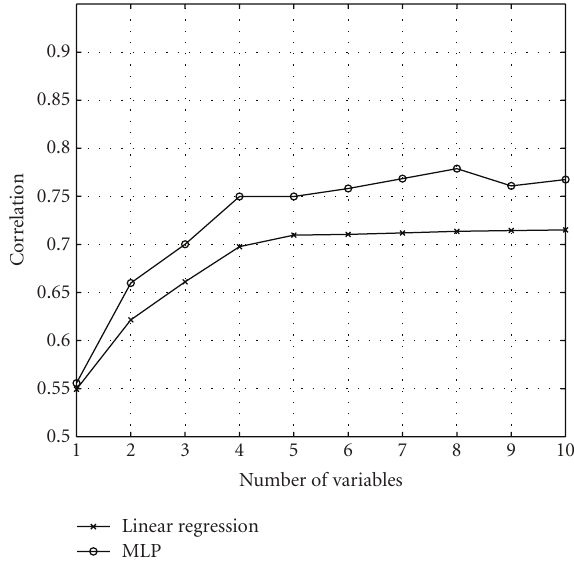
Table 4: Variables selected for turbidity using multilayer percep- trons. Figure 2: Evolution curves for turbidity. The goodness of the model improves at first as variables are added, but then the improvement gradually stops.